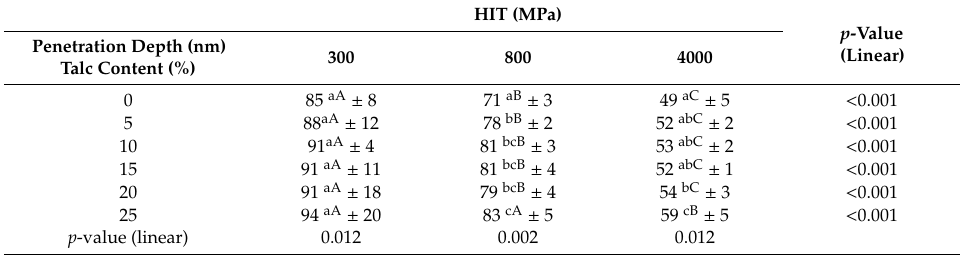
Table 1. The mean values of indentation hardness (HIT) measured for di ff erent depths with corresponding standard deviations, linear contrast, and post-hoc analysis results.